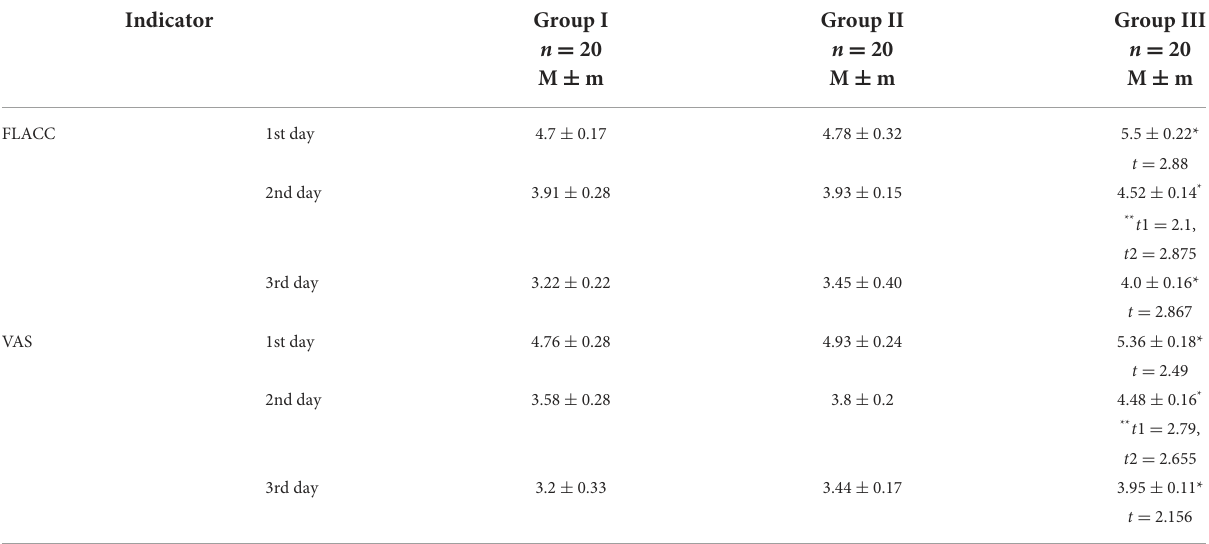
TABLE 3 Scales for assessing acute pain in patients.